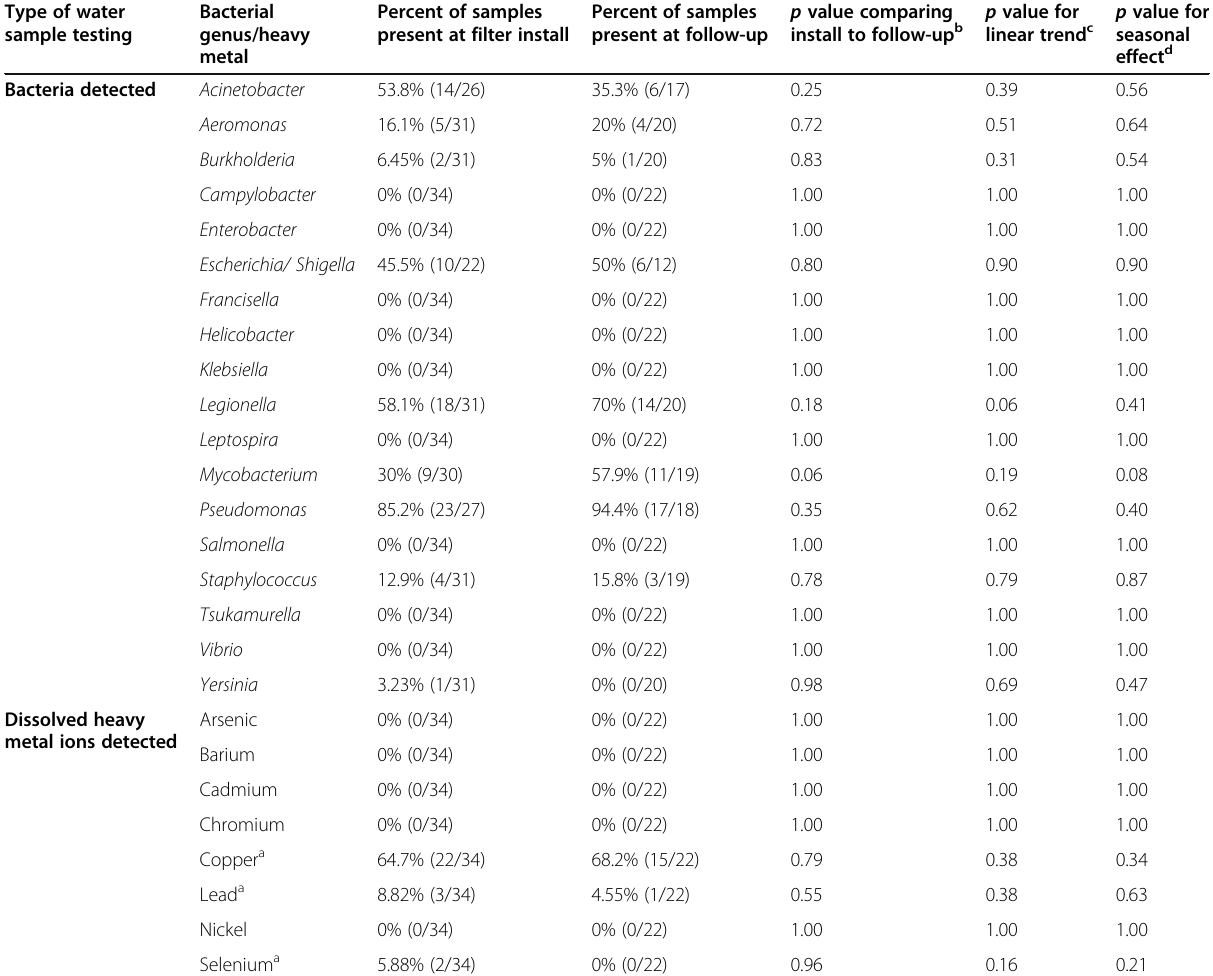
Table 7 Summary of test results of source water (unfiltered) Type of water sample